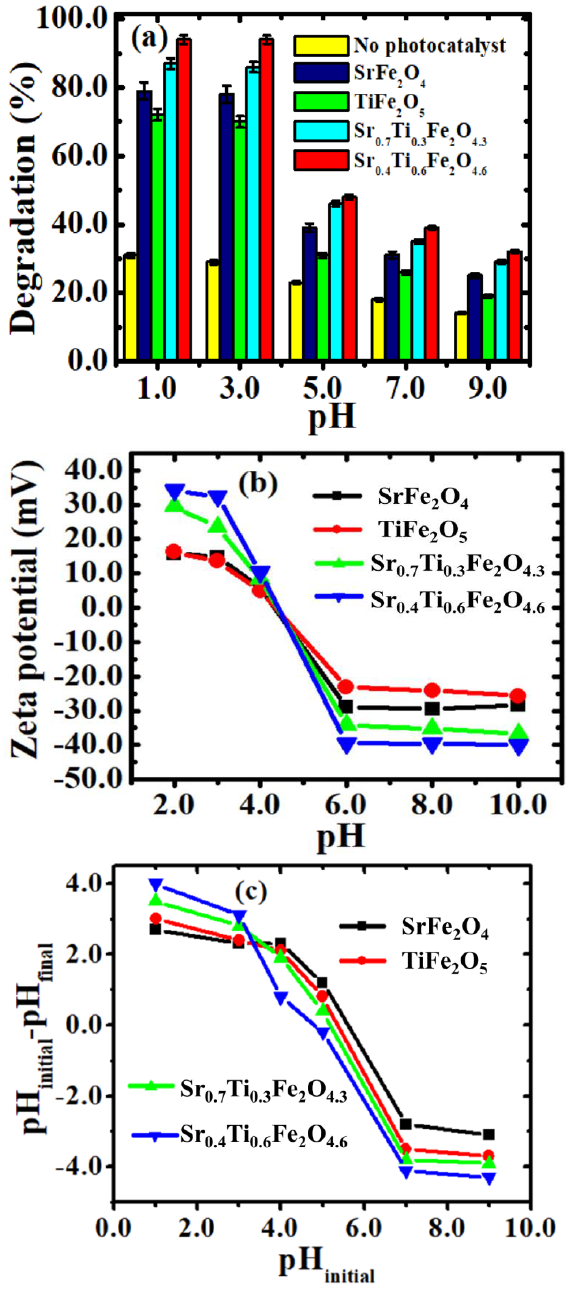
Figure 8. ( a ) Photocatalytic degradation of ( a ) p -nitrophenol under visible-light irradiation (experi- mental conditions: catalyst dose, 0.2 g/L; irradiation time, 2 h) ( b ) Zeta potential curve and ( c ) pH ZPC of synthesized Sr 1-x Ti x Fe 2 O 4+δ (x = 0.0 — 1.0) ferrite NPs.